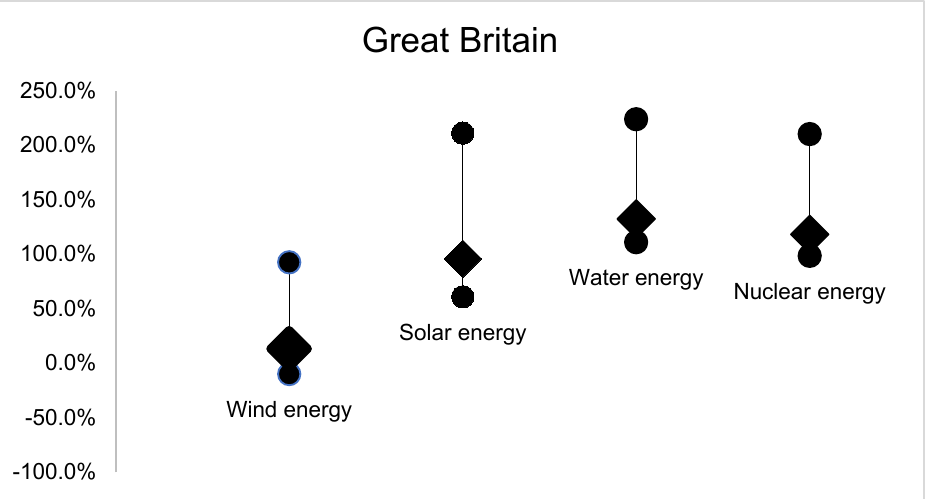
Figure 9. Willingness to pay for various types of electric energy in Great Britain . Source: own study.